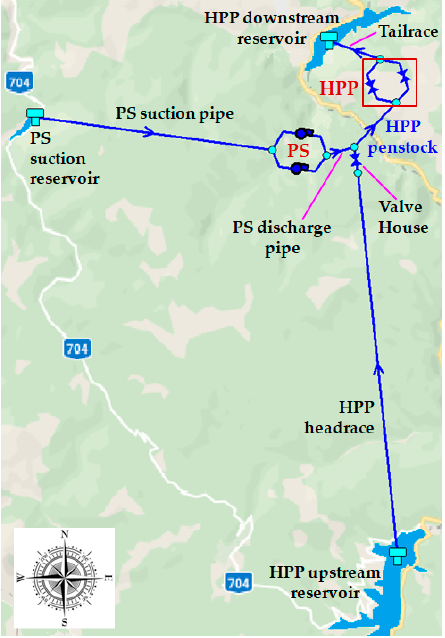
Figure 2. Numerical model of the hydropower facility, built in EPANET: Gâlceag HPP (2 turbines as general purpose valves); Gâlceag PS (2 pumps); 3 tanks (HPP upstream/downstream reservoirs and PS suction reservoir); 5 pipes (HPP headrace/penstock/tailrace and PS suction/discharge pipes); Valve House (as throttle control valve); 6